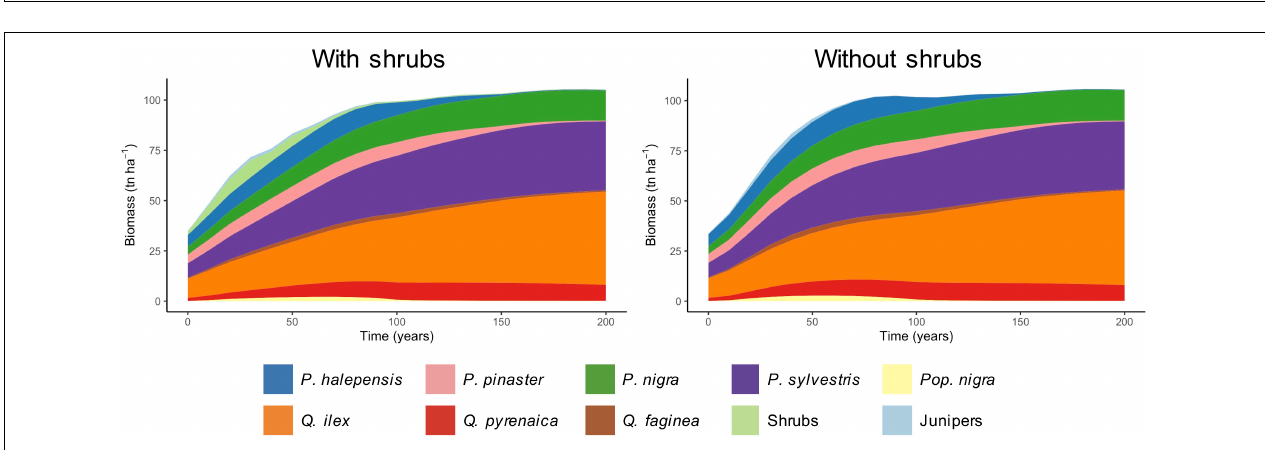
FIGURE 5 | Mean simulated annual total biomass (wood, roots and foliage) (A,C) and monthly net photosynthesis (B,D) for the two chosen forest types. Shaded area refers to standard deviation. Values of net photosynthesis are averages between years 50–75, with error bars indicating standard deviation. Note that lines connecting the points serve for illustrative purposes only, since PnET-Succession simulates photosynthesis at monthly time scale (not daily).